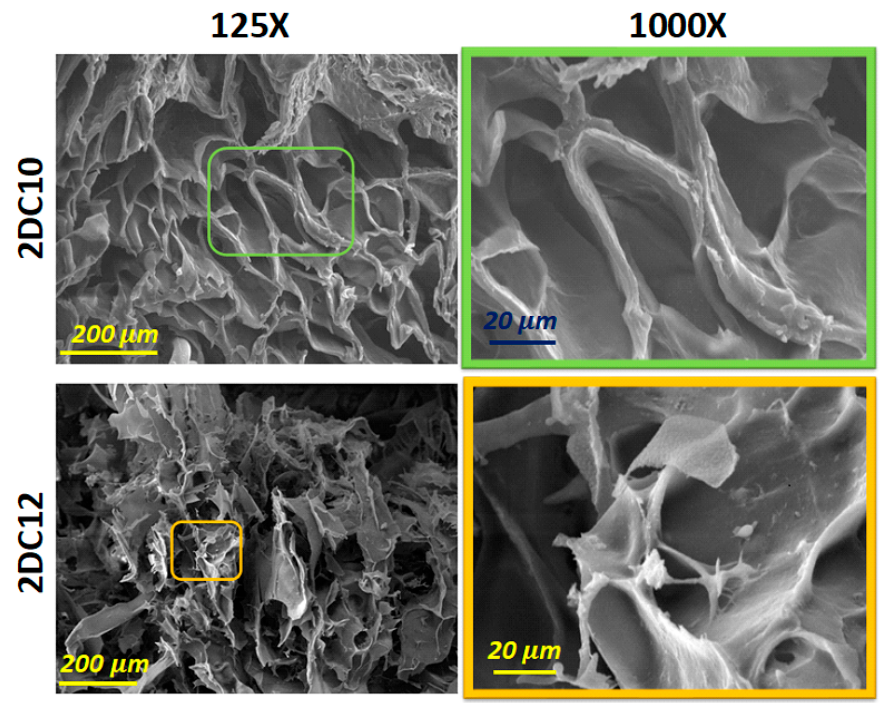
Figure 4. SEM micrograph of 2DC10 and 2DC12 hydrogels.